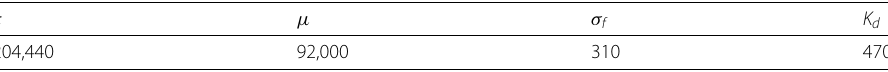
Fig. 9 Comparison of deterministic homogenisation result (det) with the Bayesian aleatoric posterior (partial) and the full posterior (total) for the shear modulus [MPa] Table 1 Mean values of random meso-scale material parameters